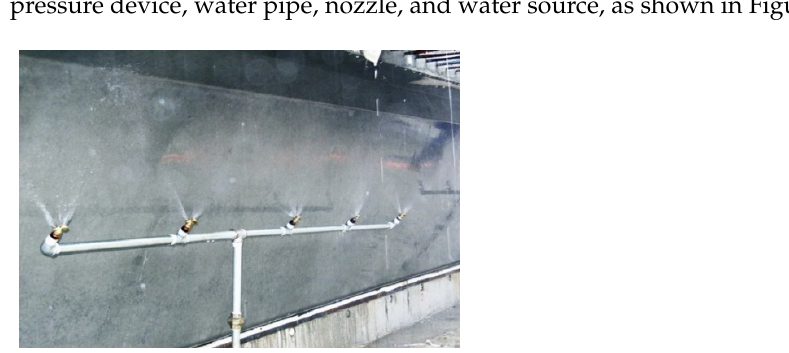
Figure 3. Automatic water spray mist curing